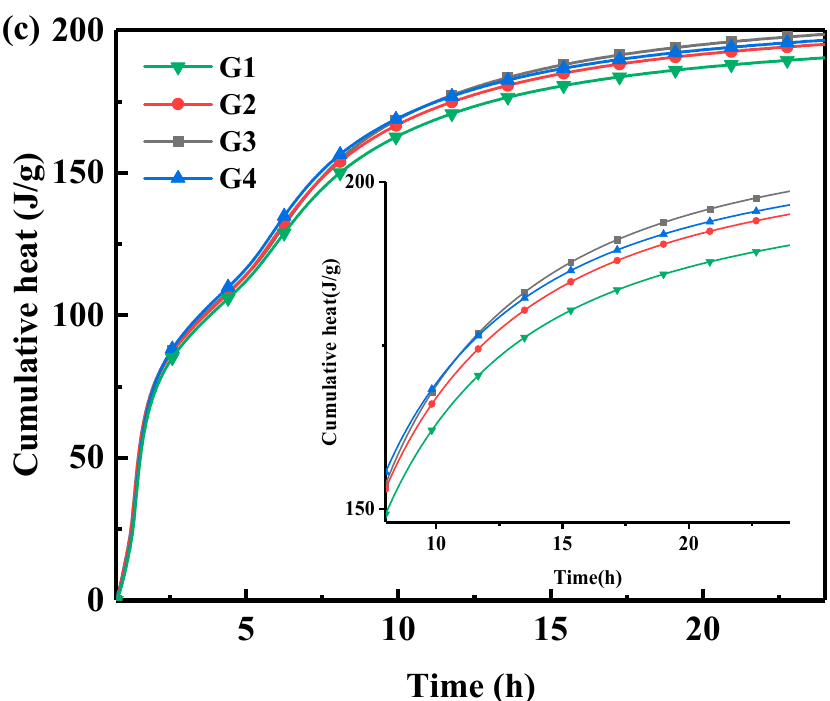
Figure 3. Hydration heat curves of sulfoaluminate cement-based materials with and without GNPs, ( a ) hydration stage, ( b ) hydration heat, and ( c ) cumulative heat.